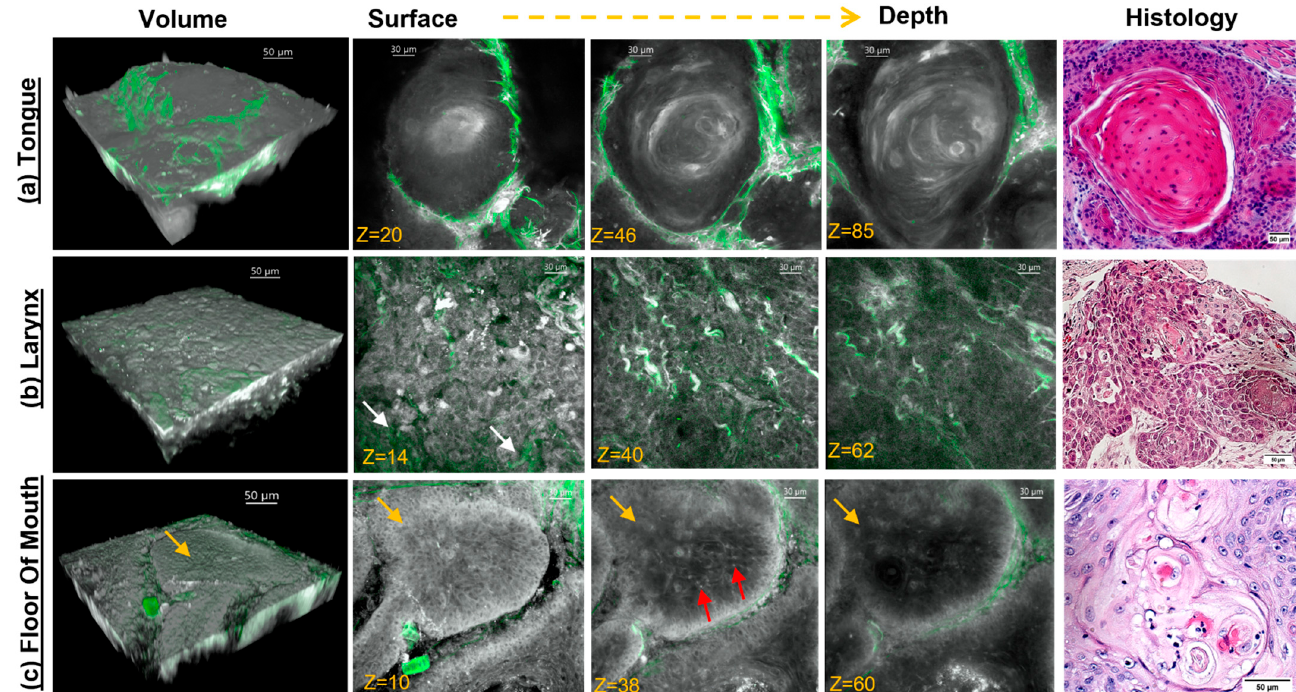
Figure 2. Volumetric and single plane MPM-SHGM images of SCC in human tongue ( a ), larynx ( b ), and floor of mouth ( c ). First panel represents a 3D reconstruction with MPAM autofluorescence in gray and SHGM from fibrillar collagen in green. Depth panels (z indicates image slice) display superficial, intermediate, and basal epithelial layers with corresponding histology shown in rightmost panel. ( a ) In tongue, a keratin pearl is seen with concentric keratin rings and surrounded by collagen (green). ( b ) A typical laryngeal tumor had superficial thick collagen bundles (identified by white arrow) interspersed among squamous epithelium, with epithelial cells identified by a bright (autofluorescent) cytosol and dark nucleus. ( c ) Floor of mouth also had similar epithelial structure. Here, a squamous island is identified by yellow arrows and surrounding collagen can be seen in green. Bright puncta (identified by red arrows) show possible inflammatory infiltrates. Scale bar in volumes and histology: 50µm. Scale bar in depth micrographs: 30 µm.